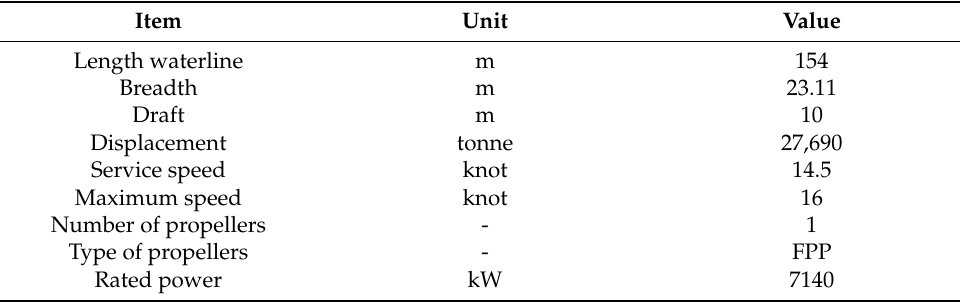
Table 1. Main characteristics of bulk